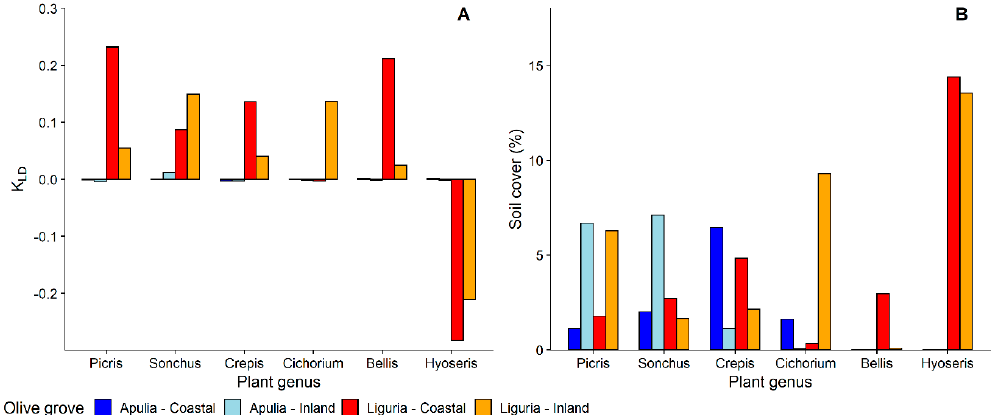
Figure 3. ( A ) Selection of most common plant genera of Asteraceae by nymphs of Philaenus spumarius —Kullback–Leibler divergence ( 𝐷 (cid:3012)(cid:3013) ) measure; ( B ) relative percentage of soil cover of most common plant genera of Asteraceae in Apulia and Liguria olive groves.